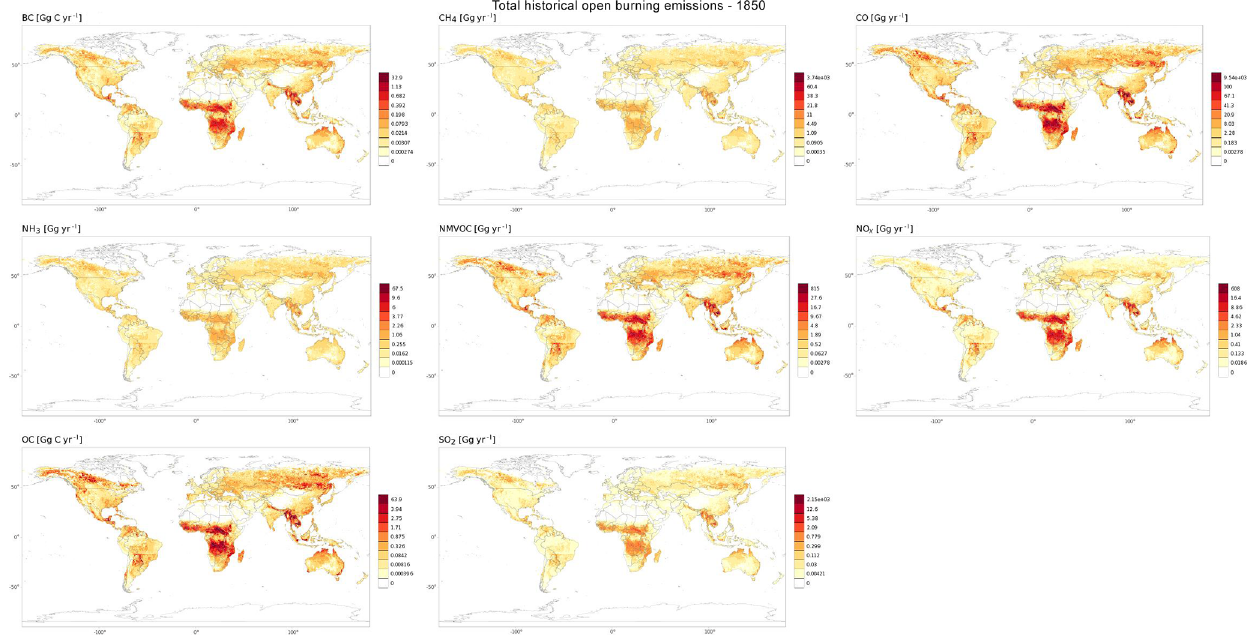
Figure 4. Total open burning emissions in 1850 by species. The color scale is the same for each emission species across all gridded figures for